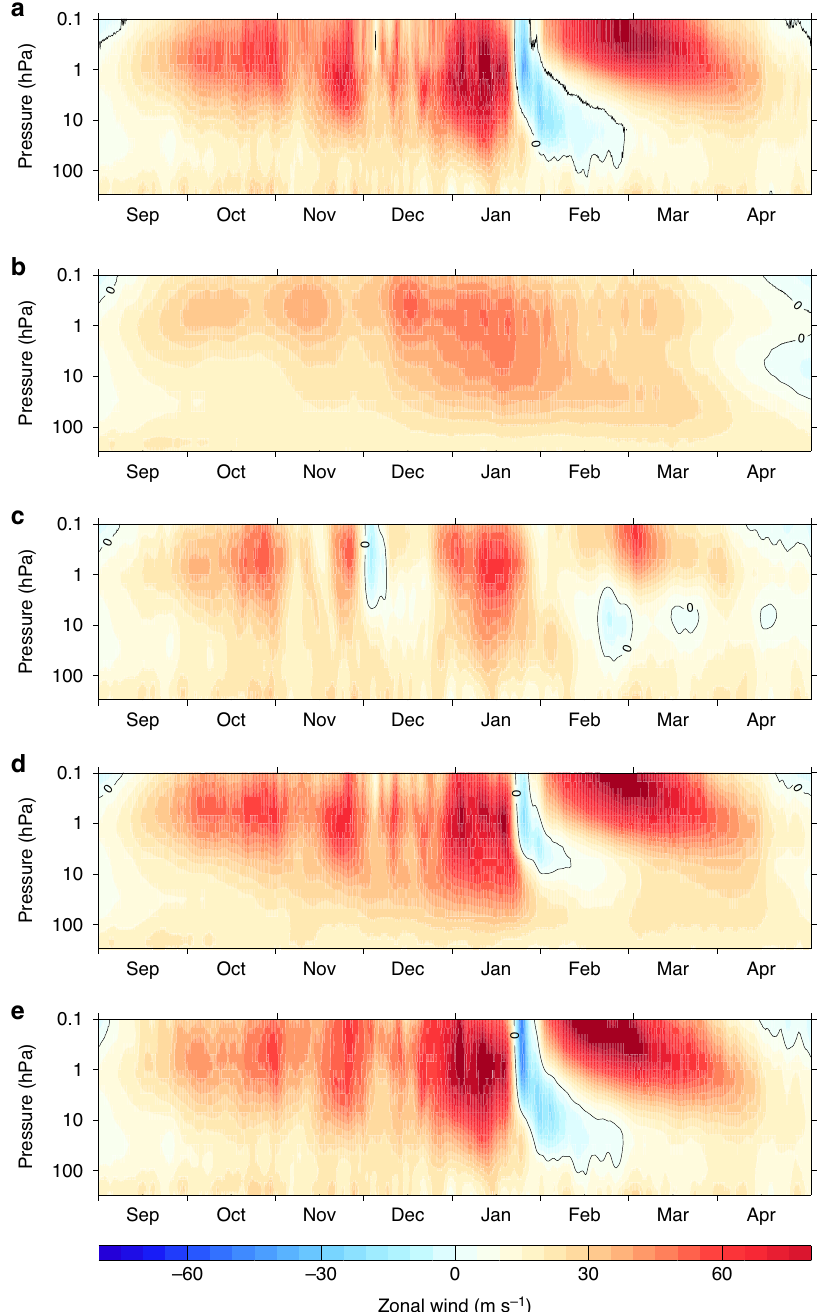
Fig. 1 Polar vortex evolution under different relaxation scenarios. Comparison of zonally averaged zonal wind (ms − 1 ) evolution at 60 o N for 2008/9 from the different model experiments. a Evolution of the European Centre Interim Reanalysis (ERA-Interim) data to indicate the observed evolution. b Ensemble average of the control run in which no relaxation was applied to the model; with only imposed sea surface temperatures at the lower surface and the correct phase of the quasi-biennial oscillation (QBO) from the initial conditions the model achieves a reasonable simulation of the vortex seasonal evolution but is unable to reproduce the observed sudden warming event in January 2009. c Ensemble average of the AllTrop experiment in which winds and temperatures from the surface to the tropopause at all latitudes were relaxed towards the ERA-Interim data; this demonstrates that imposing the tropospheric wave forcing enables the model to successfully simulate a sudden warming event, but its timing and penetration depth are incorrect. d Ensemble average of the UpStrat experiment in which the winds and temperatures in the upper stratosphere above 5hPa at all latitudes were relaxed towards ERA-Interim data; this indicates that even when the correct timing of the warming event is imposed the model is unable to correctly reproduce the vertical extent of the warming event deep into the lower stratosphere. e Ensemble average of the AllTrop-UpStrat-Eq experiment in which the winds and temperatures from the surface to the tropopause were relaxed toward the ERA-Interim data at all latitudes (as in the AllTrop experiment), and additionally the zonal winds in the upper equatorial stratosphere between 0 and 10 o N above 5hPa were relaxed towards ERA-Interim data; the polar vortex evolution from this experiment is remarkably similar to the observed evolution, indicating that the combination of realistic tropospheric wave forcing and realistic equatorial winds at all heights in the stratosphere and lower mesosphere (i.e., the correct phasing of the quasi-biennial oscillation in the lower stratosphere from the initial conditions and the semi-annual oscillation (SAO) from the imposed relaxation) is required to successfully reproduce the timing and depth of the observed warming